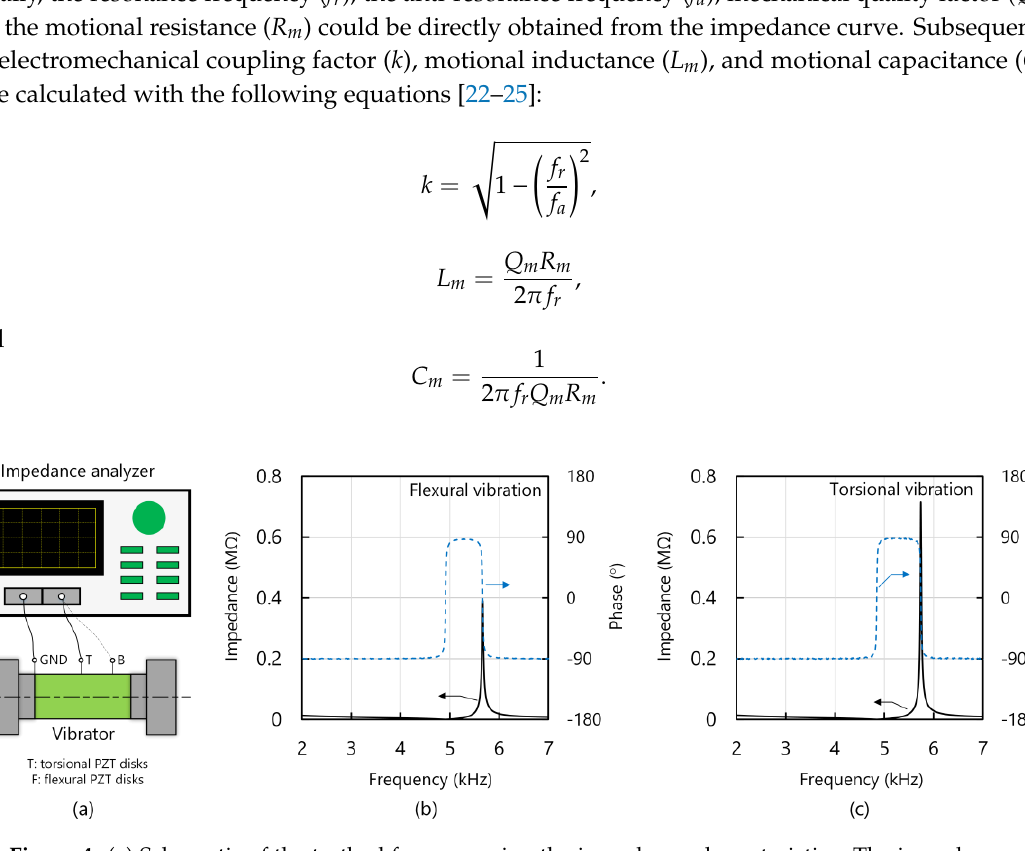
Figure 4. ( a ) Schematic of the testbed for measuring the impedance characteristics. The impedance characteristics corresponding to ( b ) the flexural vibration and ( c ) the torsional vibration. Table 2. Equivalent circuit parameters of the T/F vibrator.